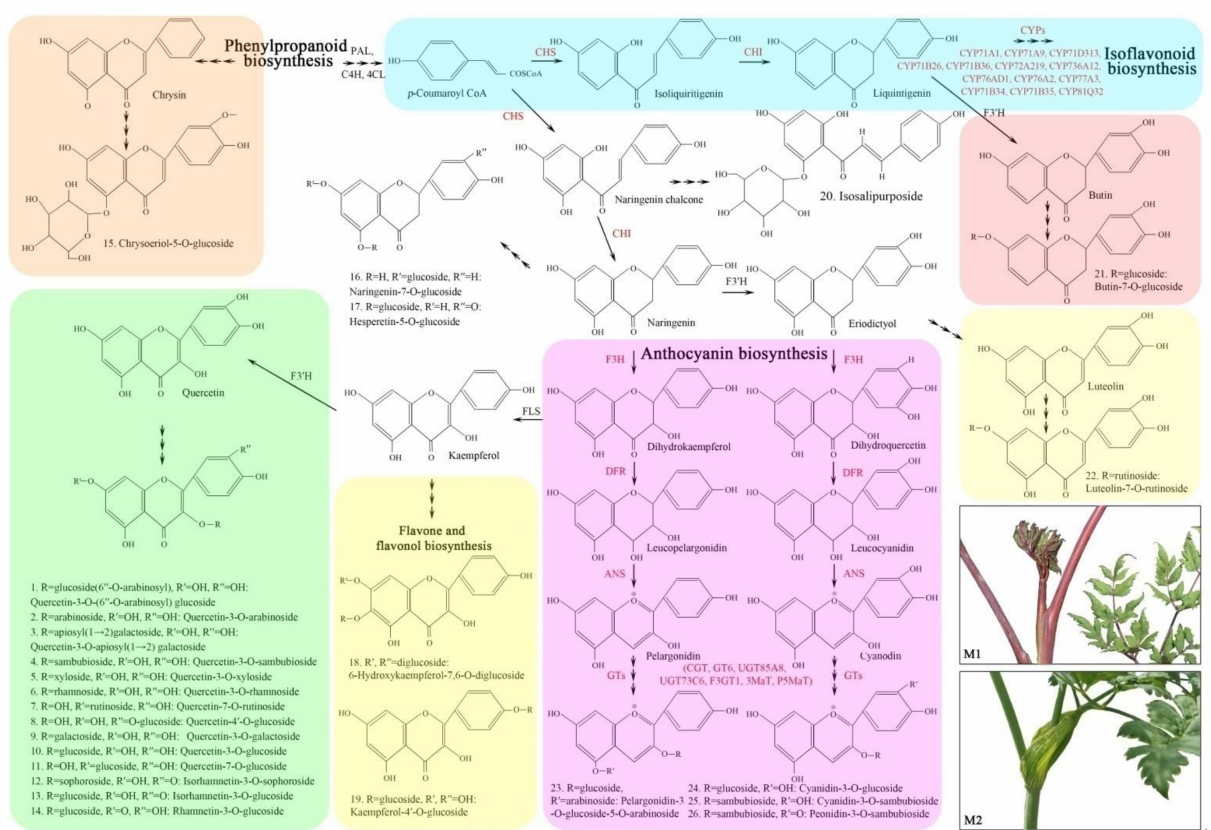
Figure 7. Proposed network of the DAFs regulated by the DEGs in M1 and M2. The 26 DAFs are listed from No.1 to No.26 (Table 1), and the enzymes encoded by the 25 DEGs are colored in red. 2.7. qRT-PCR Validation of Candidate Genes Involved in Flavonoid